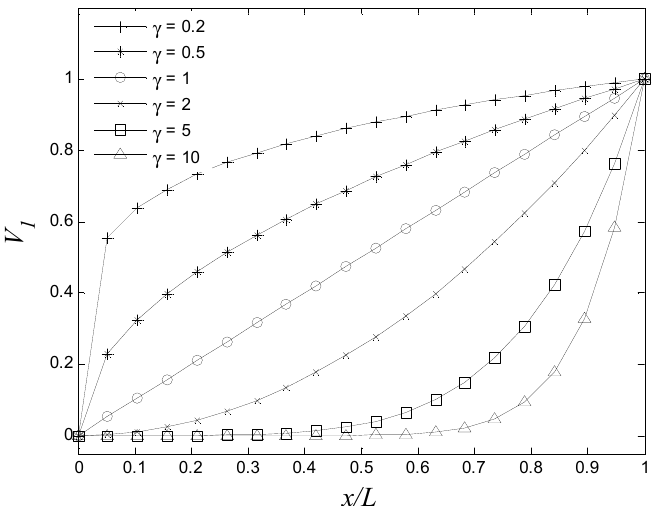
Figure 2. Variations of volume fractions based on simple power law (Equation (1)).